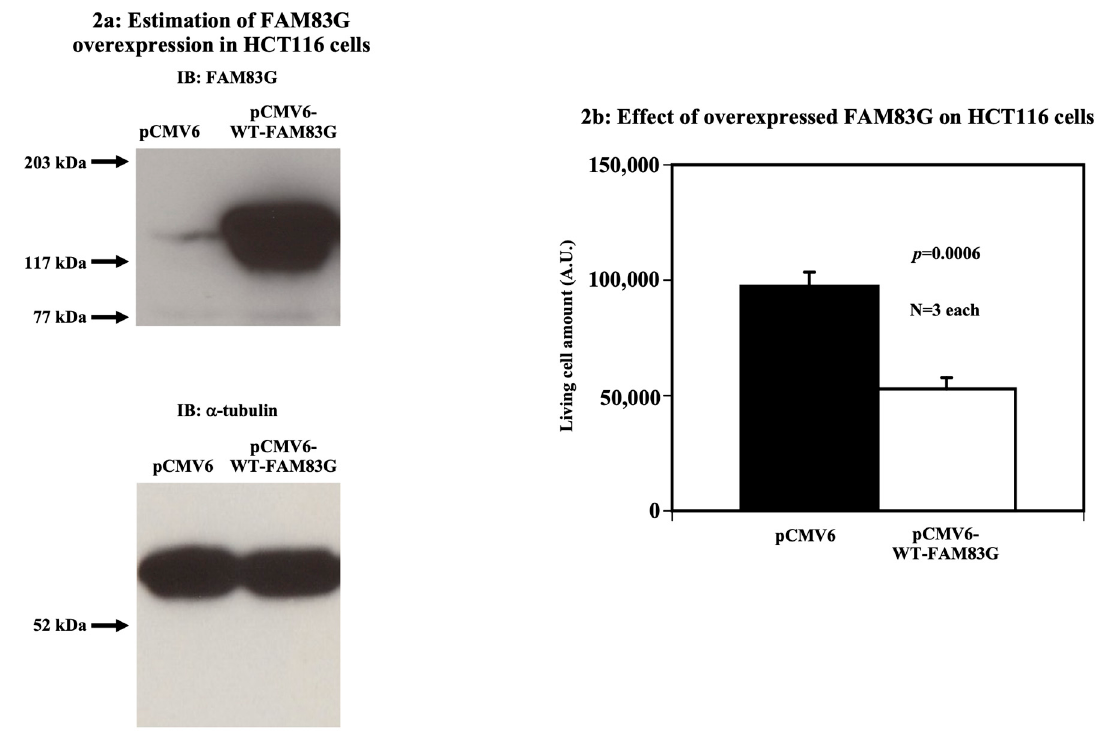
Figure 2. E ff ect of FAM83G overexpression on HCT116 cells. ( a ) Estimation of FAM83G overexpression in HCT116 cells. The amount of overexpressed wild type (WT)-FAM83G in HCT116 cells was ~10-fold greater than that of endogenous FAM83G (upper panel). α -tubulin blotting proved that equal protein amounts were loaded in each sample (lower panel). The experiments were independently performed in triplicate. ( b ) Overexpressed WT-FAM83G reduces the number of live HCT116 cells; relative live HCT116 cell numbers were quantified using the LIVE / DEAD cell assay following the expression of an empty pCMV6 vector (control) or pCMV6-WT-FAM83G. The results of the statistical analyses are shown: WT-FAM83G overexpression significantly reduced the number of live cells. The experiments were independently performed in triplicate.